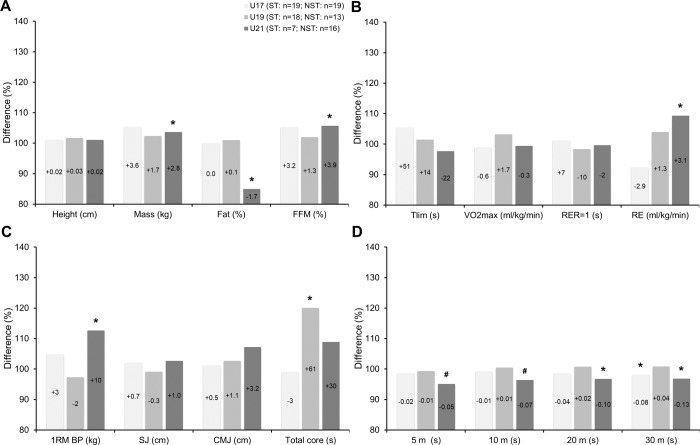
Differences in anthropometric characteristics (A) and physical capacities (B-D) between starting and nonstarting elite junior soccer players within U17, U19, and U21 age groups. Bars show relative differences in relation to starting players. Within bars, absolute differences in relation to starting players are also shown. U17, U19, and U21 = Under 17, 19 and 21 years old players; n = Sample size; ST = Starting players; NST = Nonstarting players; FFM = Fat-free mass; Tlim = Time to exhaustion; VO2max = Maximum oxygen uptake; RER = Respiratory exchange ratio; RE = Running economy; 1RM = One repetition maximum; BP = Bench press; SJ = Squat jump; CMJ = Counter movement jump; * = Moderate effect size; # = Large effect size.